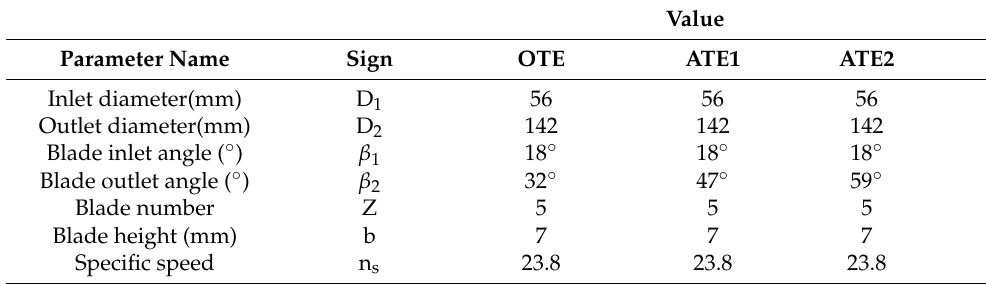
Table 1. Geometric parameters of the suction side of impellers and the model pump.